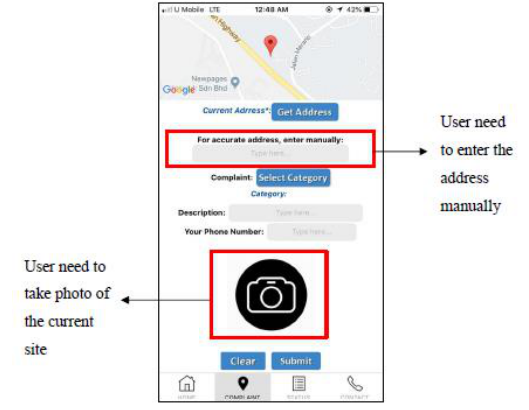
Figure 10. Information input needed from the